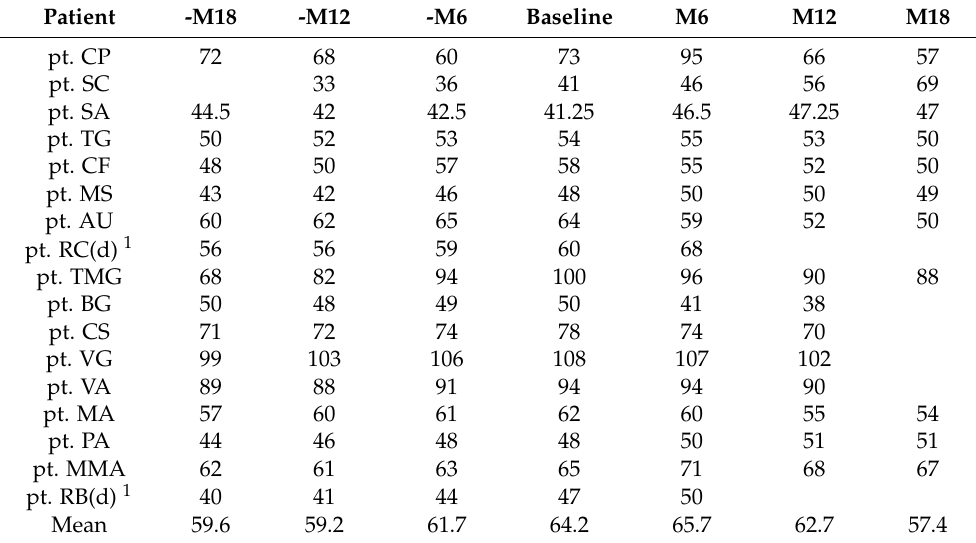
Table A4. Norfolk QOL-DN